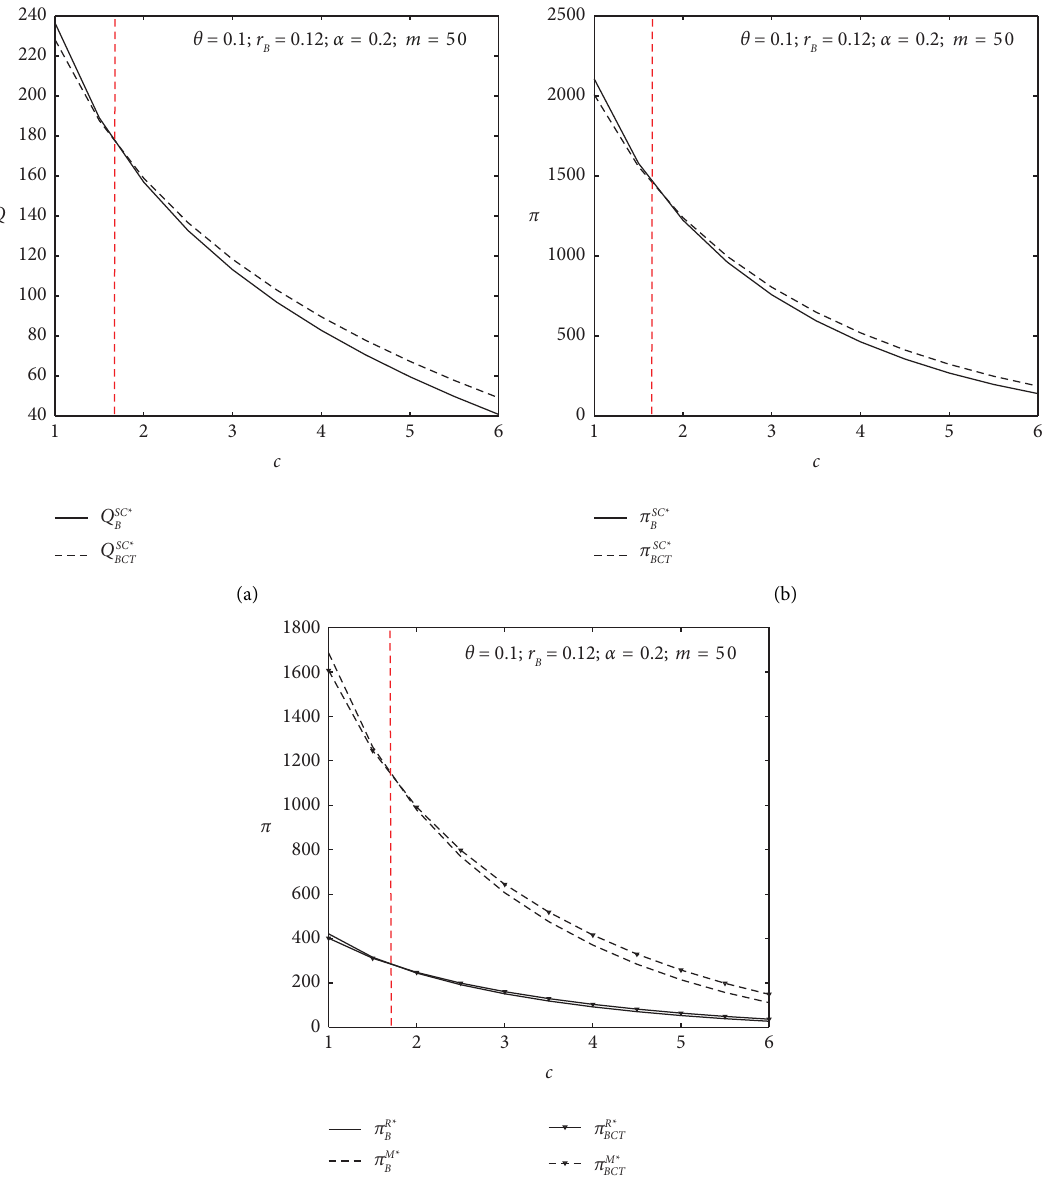
Figure 1: Te impact of production cost on the efciency of diferent fnancing